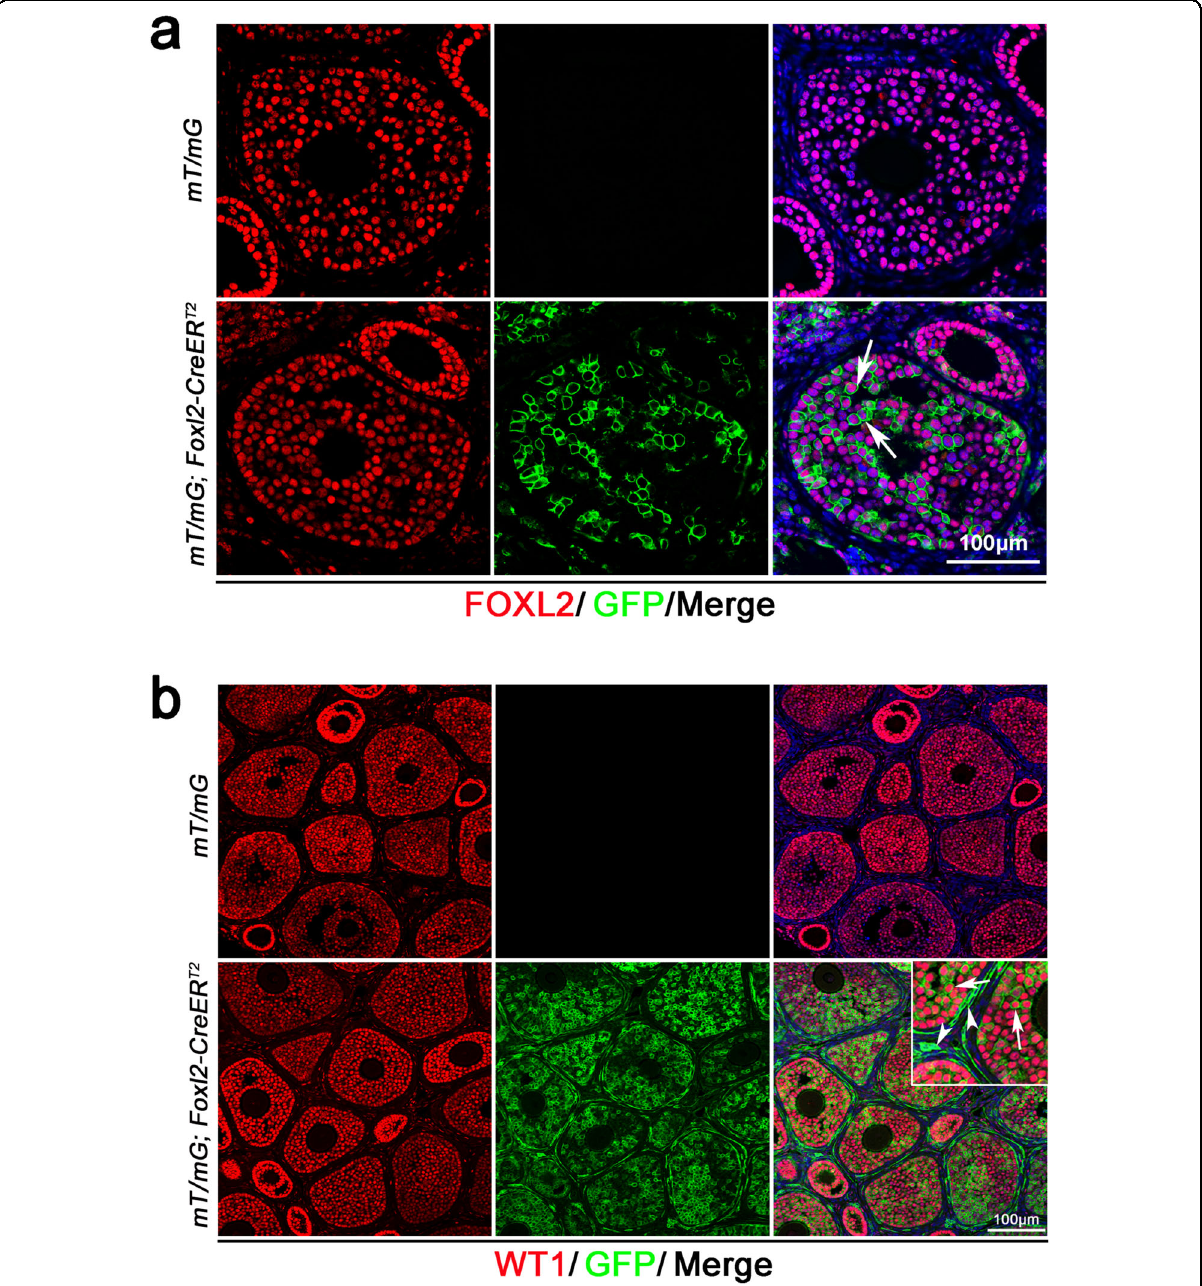
Fig. 2 Lineage tracing of Foxl2 -expressing cells in the fetal ovary with Foxl2-CreER T2 mice. a No GFP were observed in theca-interstitial cells when Foxl2-CreER T2 mice was induced with tamoxifen at 3 weeks of age. mT/mG; Foxl2-CreER T2 mice were induced with tamoxifen at 3 weeks of age and the GFP signal was examined by immunostaining. No GFP signal was detected in the ovaries of mT/mG mice after tamoxifen induction. GFP signal was only detected in FOXL2-positive granulosa cells (bottom panel, white arrows) of mT/mG; Foxl2-CreER T2 mice and no GFP signal was detected in theca-interstitial cells. b GFP-positive cells were observed as both granulosa cells and theca-interstitial cells of mT/mG; Foxl2-CreER T2 mice when Cre was induced with tamoxifen at E13.5. mT/mG; Foxl2-CreER T2 mice were induced with tamoxifen at E13.5 and GFP signal was examined by immunostaining at 3 weeks of age. No GFP signal was detected in the ovaries of mT/mG mice after tamoxifen induction (top panel). GFP signal was detected in both WT1-positive granulosa cells (inset, white arrows) and WT1-negative theca-interstitial cells (inset, white